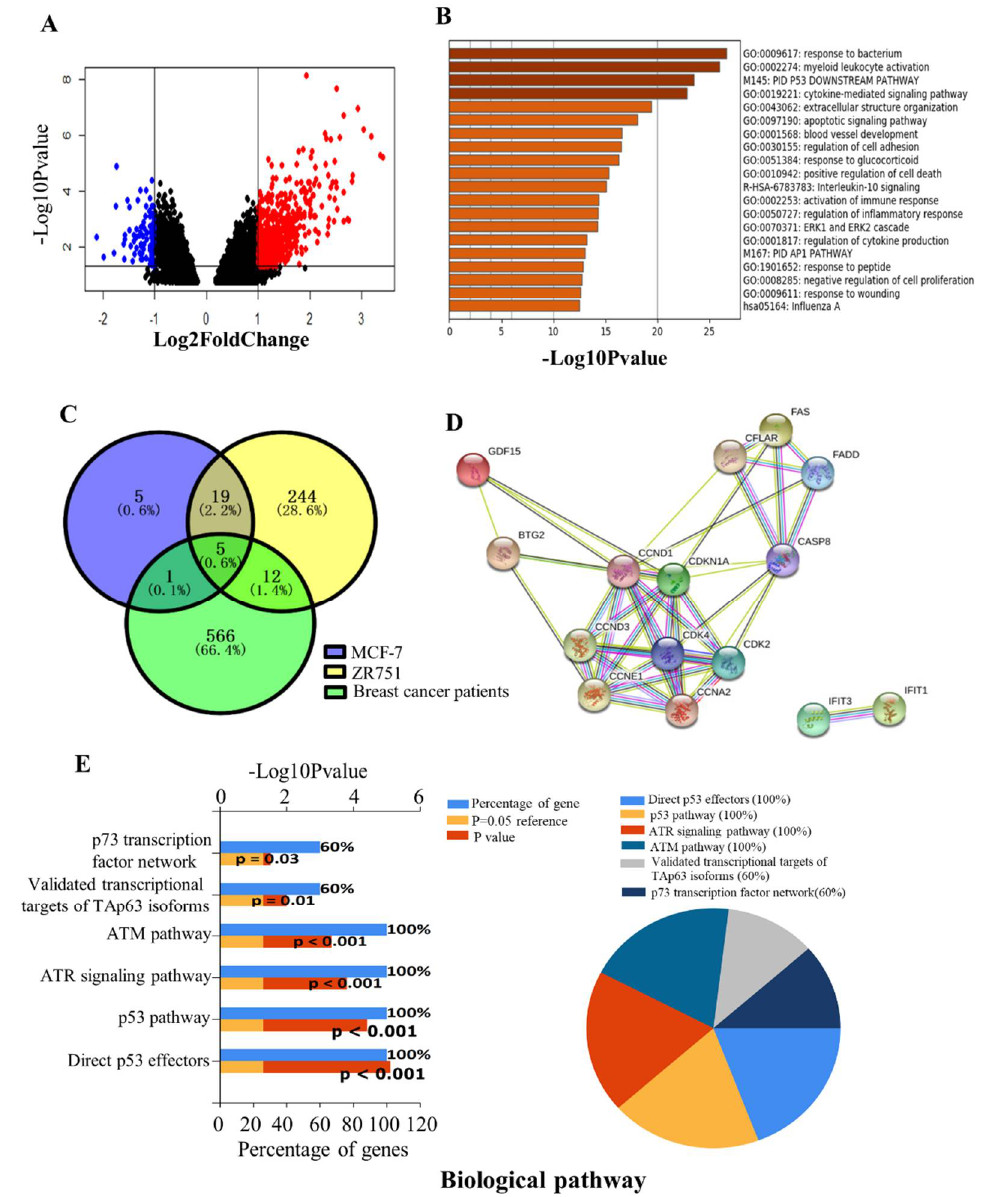
Figure 2. Identification of DEGs in the breast cancer patients of the GSE59733 dataset and the functional analysis of the overlapping DEGs between the GSE59732 dataset and GSE59733 dataset. ( A ) Volcano plots showing 585 DEGs in the tumor samples of breast cancer patients pre- and post- radiotherapy. Red and blue dots represent the up-regulated and down-regulated genes based on an adjusted p < 0.05 and |log 2(FC)| > 1. Black dots: no significant change. ( B ) Metascape analysis of the enriched pathways of above 585 DEGs. ( C ) Venn diagrams of DEGs in MCF-7 and ZR751 cell lines from GSE59732 dataset and breast cancer patients from GSE59733 dataset. A total of 5 intersecting genes (GDF15, IFIT1, CDKN1A, FAS, BTG2) were screened out and were all up-regulated. ( D ) The PPI network of these 5 DEGs and their related genes, created by the online tool STRING. ( E ) The biological pathways of DEGs were analyzed by the FunRich and showed as a bar chart ( left ) and pie chart ( right ), respectively. In the bar chart, the upper x -axis represents the p -value ( − log10), and the lower x -axis represents the percentage of genes (blue). The y -axis represents the GO terms. Yellow represents the reference p -value 0.05, and red represents the specific p -value. The longer the rectangular zone, the smaller the p -value is. In the pie chart, each color represents a signaling pathway, and the proportion of DEGs participating in each signaling pathway in the 5 total DEGS showed in the form of the